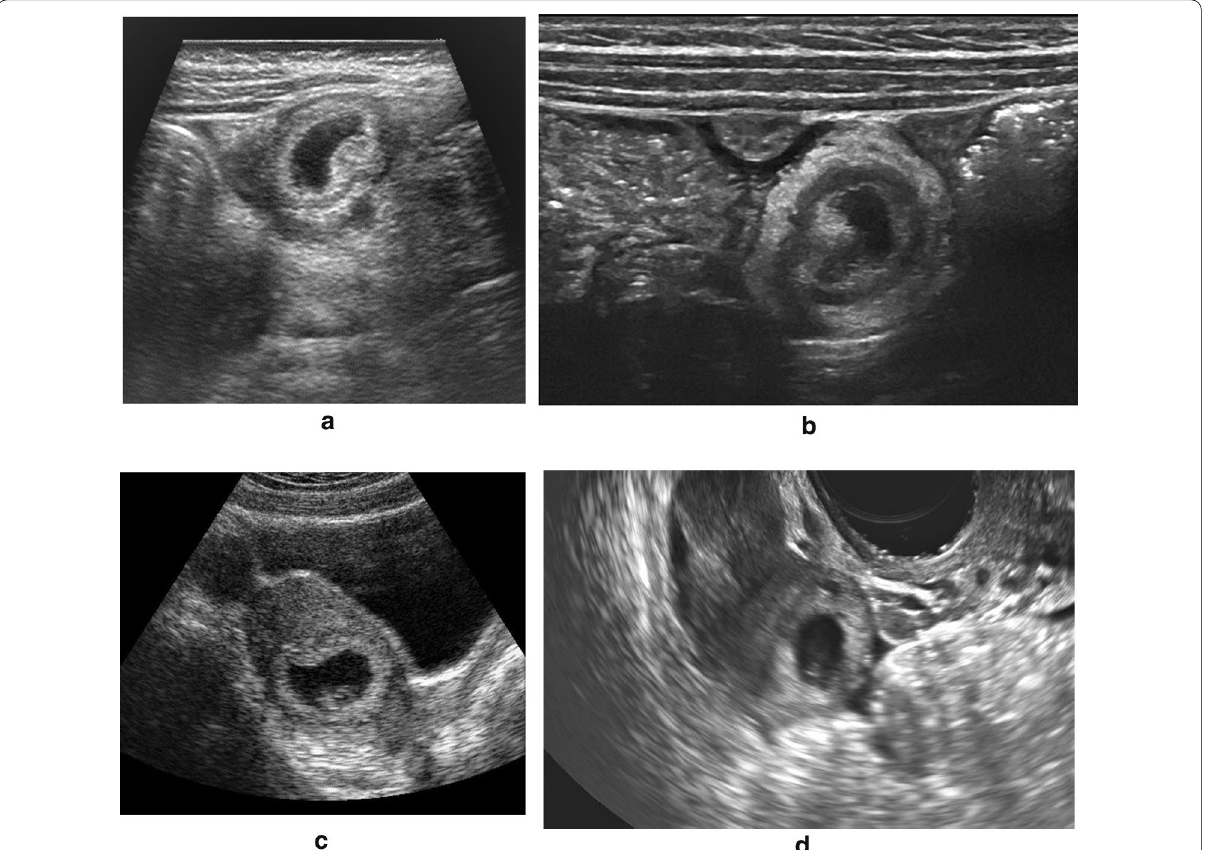
Fig. 1 Pseudogestational sac sign. a , b 18‑month‑ and 20‑month‑old boys with bleeding per rectum showing blind‑ended cystic masses with thick echogenic walls and clear or turbid content resembling an early intrauterine or extrauterine gestational sac. c , d 25‑year‑ and 32‑year‑old women with early intrauterine and extrauterine (ectopic) gestational